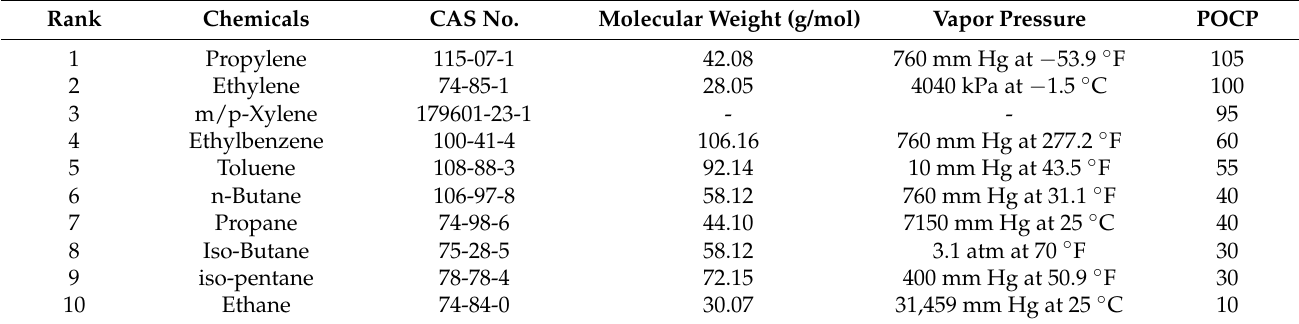
Table 2. Top 10 VOCs with high